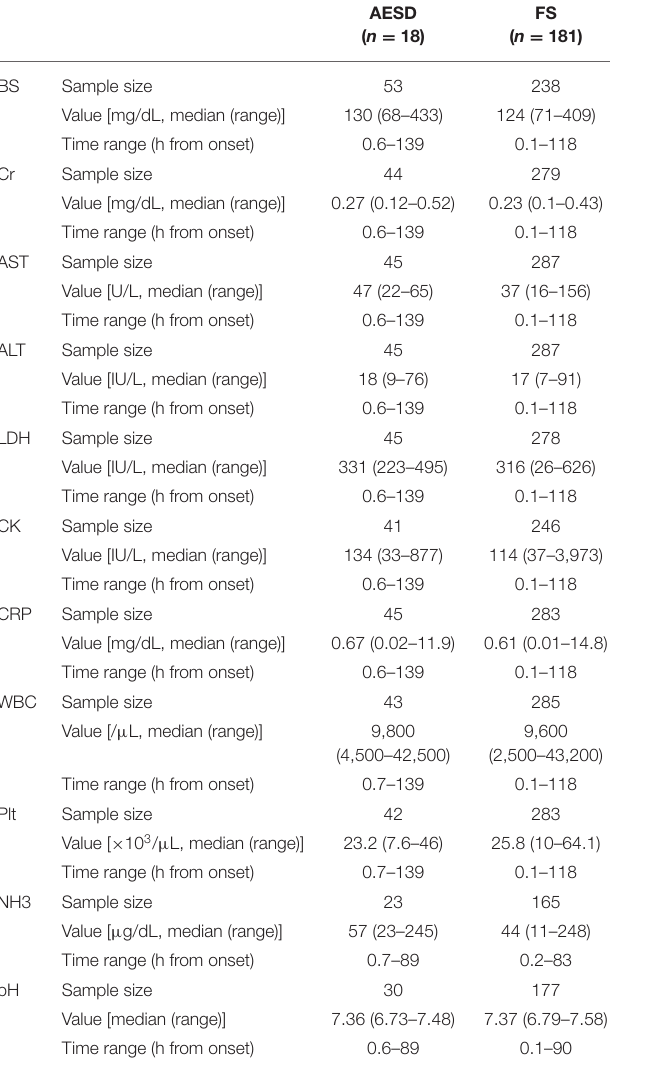
TABLE 3 | Multivariate analyses for variables associating with each laboratory datum.